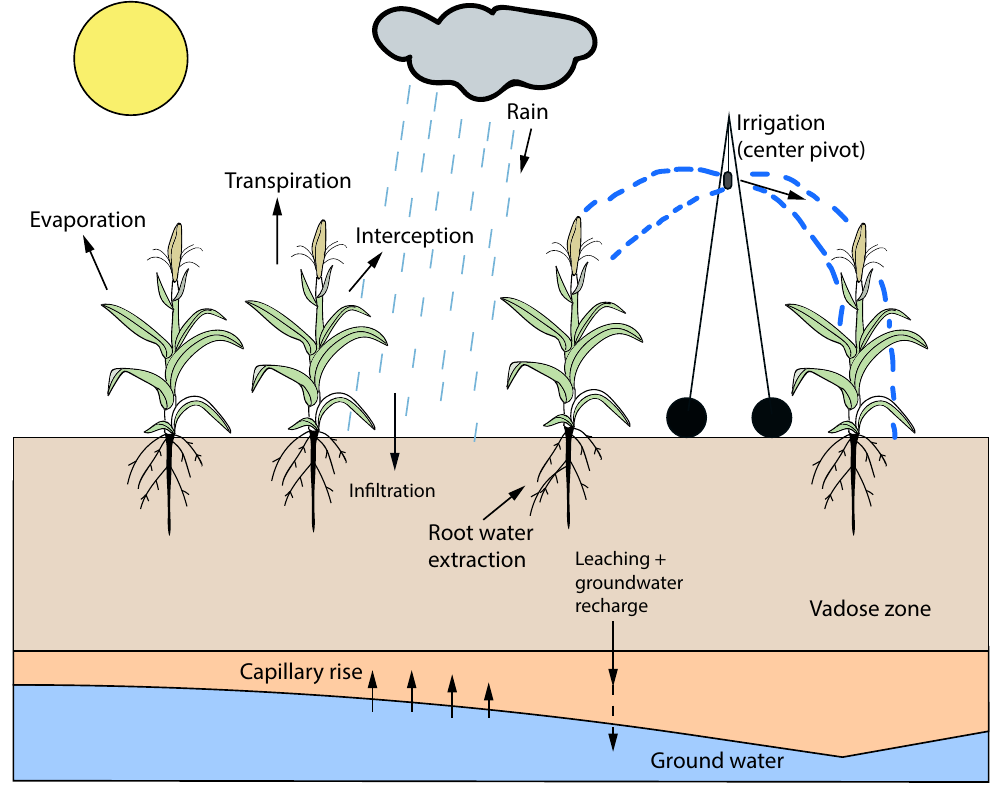
Figure 1. A schematic diagram of an agro-hydrological